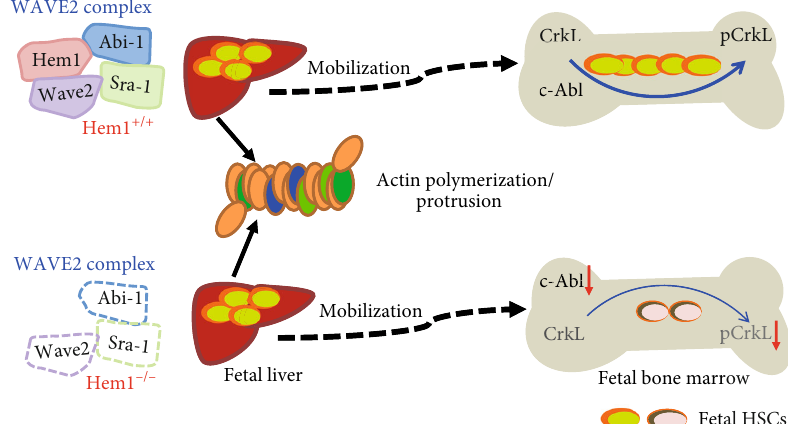
Figure 5: WAVE2 complex regulates fetal liver HSC mobilization into the bone marrow by modulating c-Abl signaling. Loss of Hem1 leads to degradation of WAVE2 complex without a ff ecting actin polymerization in fetal liver HSCs. Lodgment of fetal liver HSCs into the bone marrow is impaired under Hem1 mutation, which is related to inhibiting c-Abl signaling pathway activation with decreasing phosphorylated CrkL